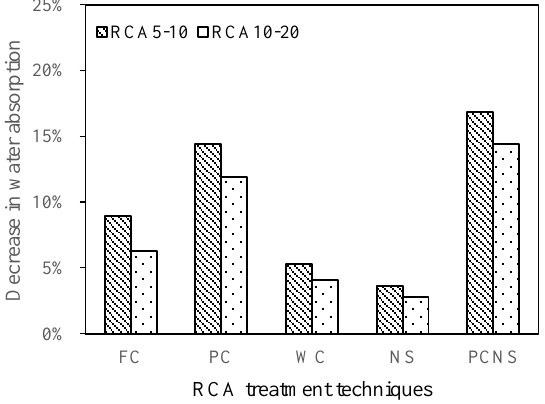
Figure 1. Decreasing rate of water absorption of RCA.